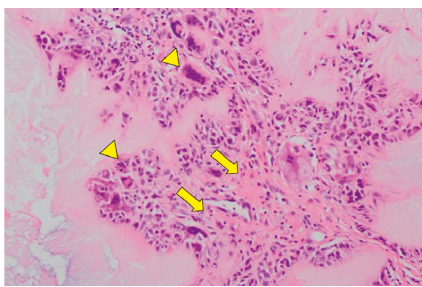
Figure 4: Photomicrograph of a section from the resected tissue specimen showing an eosinophilic amorphous tophaceous deposit surrounded by chronic inflammatory cells and multinucleated giant cells (arrow heads) and surrounded by fibrillations around them (arrows) (H&E stain, ×